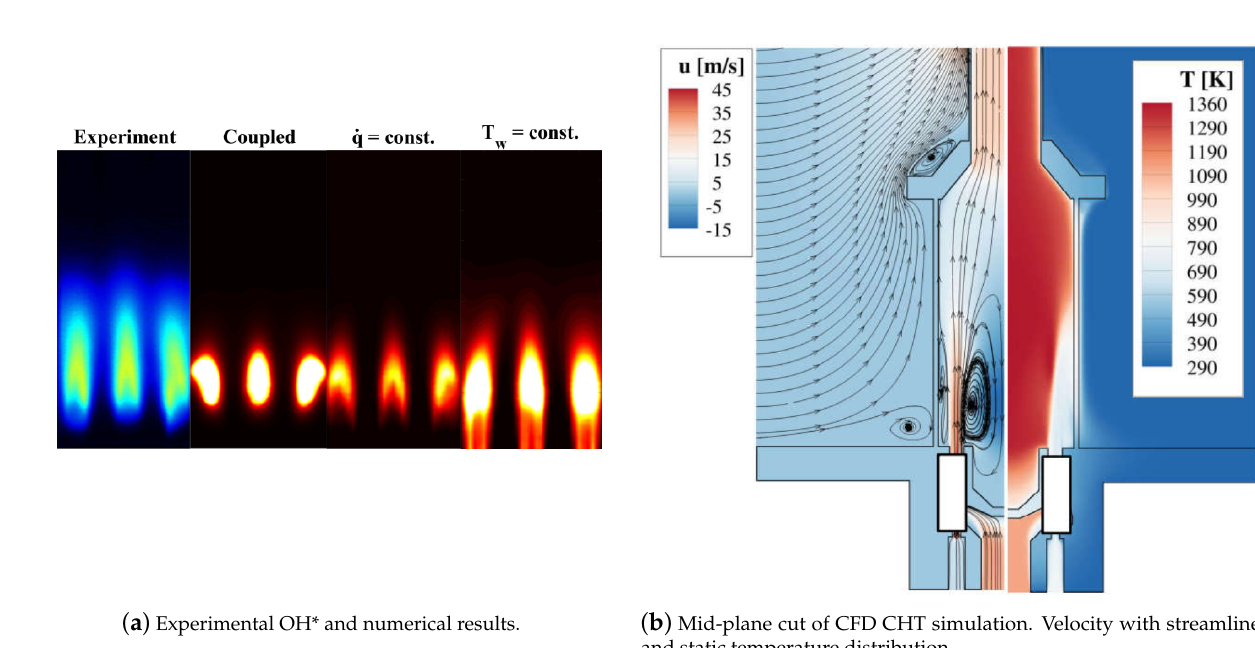
Figure 6. Experimental and numerical results of nominal load, optimum